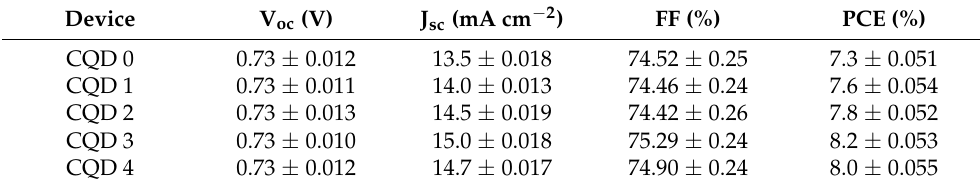
Table 3. Summary of J-V measurements of DSSC at different CQD coating cycles.